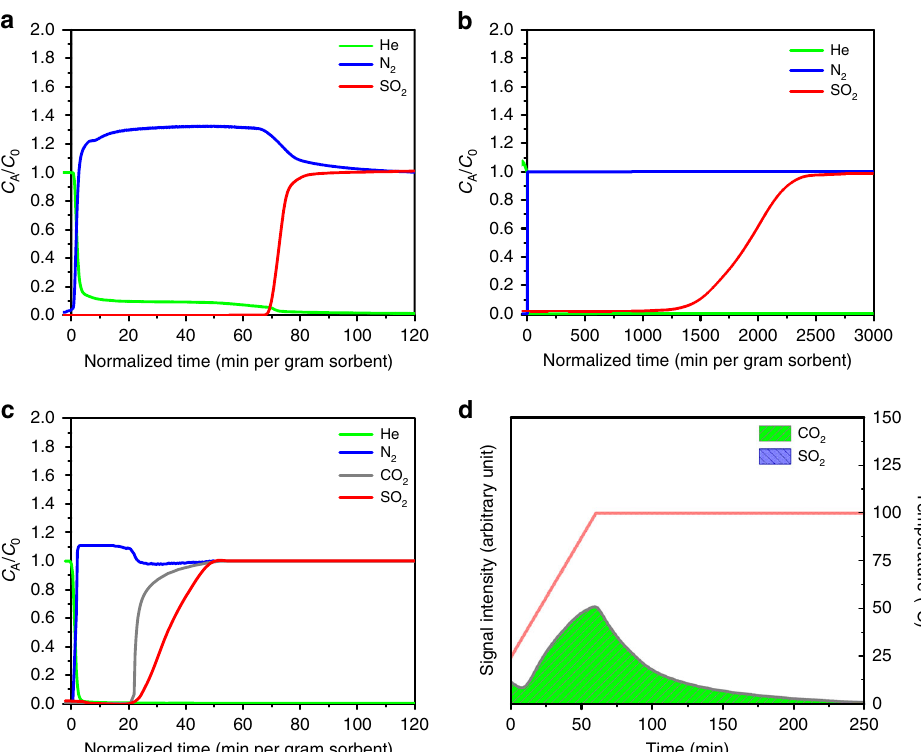
Fig. 3 CO 2 /SO 2 capture performance of KAUST -7 . Adsorption column breakthrough experiments for KAUST -7 with a SO 2 /N 2 : 7/93 mixture (10cm 3 min − 1 , fl ow rate), b SO 3 min − 1 , fl ow rate), and c SO 3 min − 1 , fl ow rate). d Temperature- 2 /N 2 : 0.05/99.95 mixture (40cm 2 /CO 2 /N 2 : 0.05/10/89.95 mixture (25cm programmed desorption after initial adsorption in the column using a mixture akin to fl ue gas (SO 2 /CO 2 /N 2 : 0.05/10/89.95), suggesting an adsorbed phase composition dominated by CO